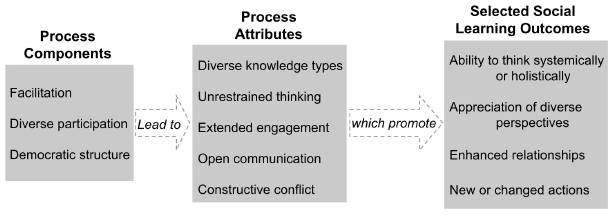
Fig. 1 . Analysis framework for social learning process components, resulting attributes, and potential outcomes. Drawn from Dana and Nelson in press , Mostert et al. 2007, Schusler et al. 2003, and Daniels and Walker